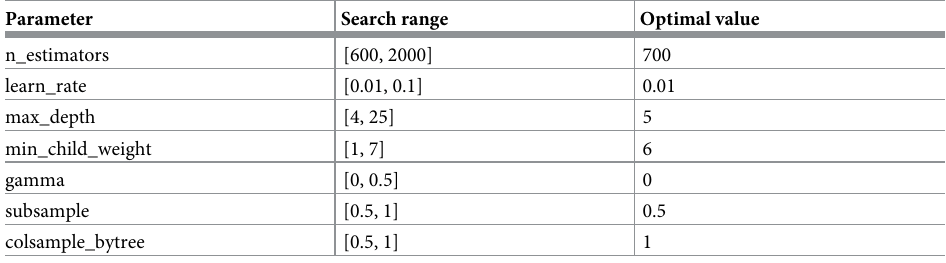
Fig 11(B). The equation of the straight line is y = − 0.07264 + 28.26 x ; the estimate of intercept is -0.07264, and the estimate of the slope is 38.36. The evolution metrics for linear regression are shown in Table 6. The performance of correction term. After exploring the relevance between pause rate and bias and predicting pause rate, we add a correction term into SPI. To verify the new Table 5. Optimal combination of